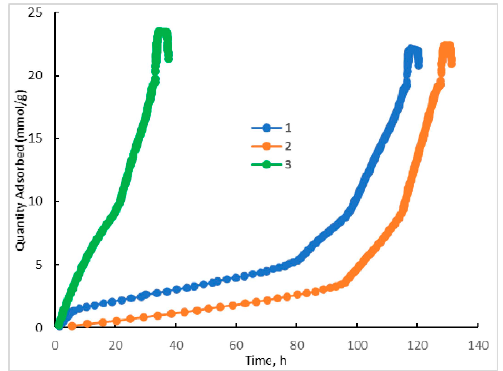
Figure 4. The time of the achievement of the adsorption equilibrium on the di ff erent isotherm plots for the HKUST-1 mw (1), HKUST-1 mw pressurized material (2), and HKUST-1 solv.1